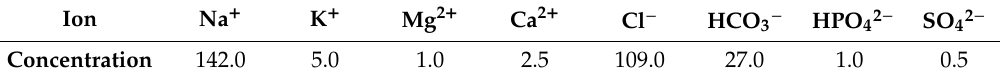
Table 2. The composition of SBF (ionic concentrations in mmol / L)